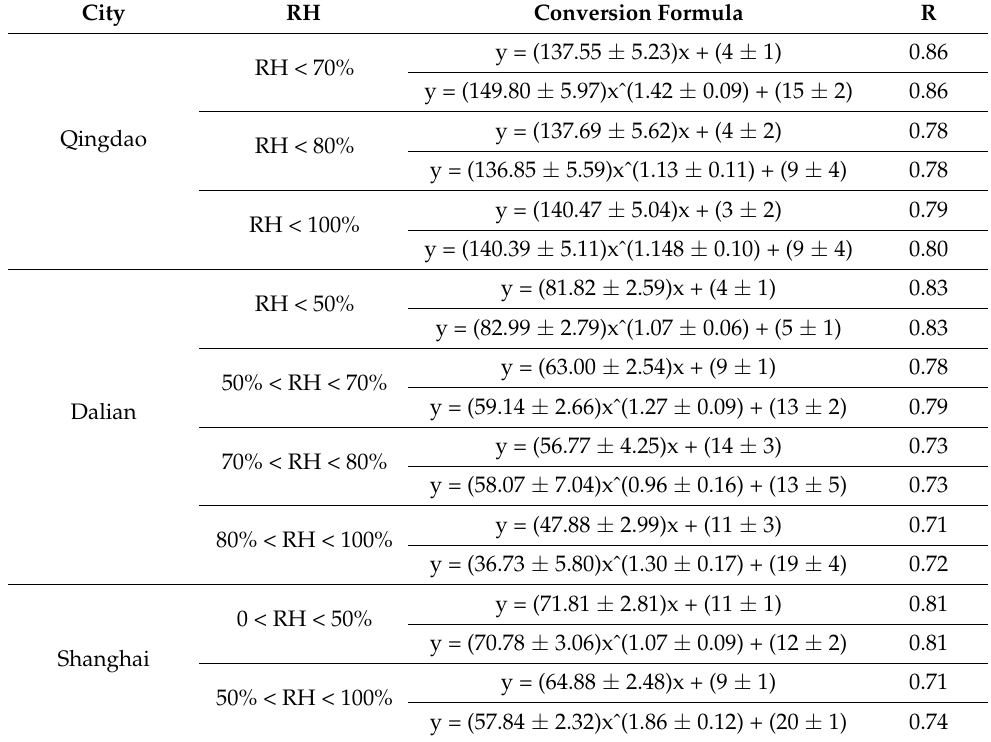
Figure 3. The relationship between the aerosol extinction and the relative humidity (RH) in Dalian ( a ), Qingdao ( b ) and Shanghai ( c ). Table 3. Conversion formulas for the aerosol extinction coefficient and the particulate matter (PM) 2.5 under different